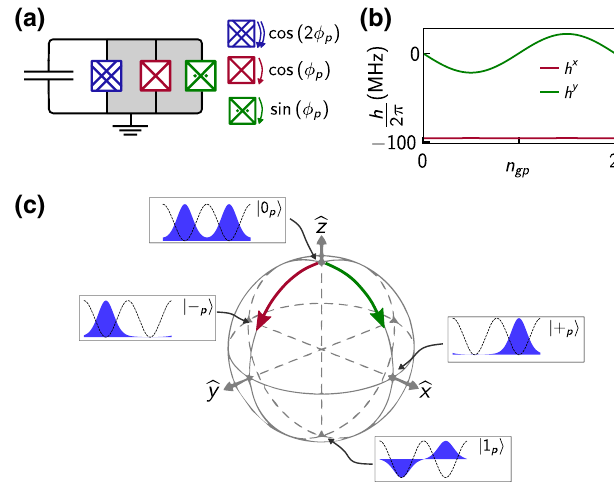
FIG. 4. Single-qubit gates. (a) A generalized PPQ circuit with three circuits elements: a cos ( 2 φ p ) element (blue), a cos (φ p ) ele- ment (red), and a sin (φ p ) element (green). No magnetic flux is threading the gray areas of the circuit. (b) The dependence of the matrix element h x (resulting from the cos (φ p ) element) and h y (resulting from the sin (φ p ) element) as a function of n g , p . The system parameters are ( E J , p , E C , p ) = 2 π( 2.7, 0.18 ) GHz and (ε x / E J , p , ε y / E J , p ) = ( 0.04, 0.2 ) . (c) The cos (φ p ) element induces rotations around the x axis of the Bloch sphere (red arrow). The sin (φ p ) element induces rotations around the y axis of the Bloch sphere. The wave functions of the PPQ in the z basis ( | 0 p (cid:3) , | 1 p (cid:3) ) and in the x basis ( |+ p (cid:3) , |− p (cid:3) ) are shown